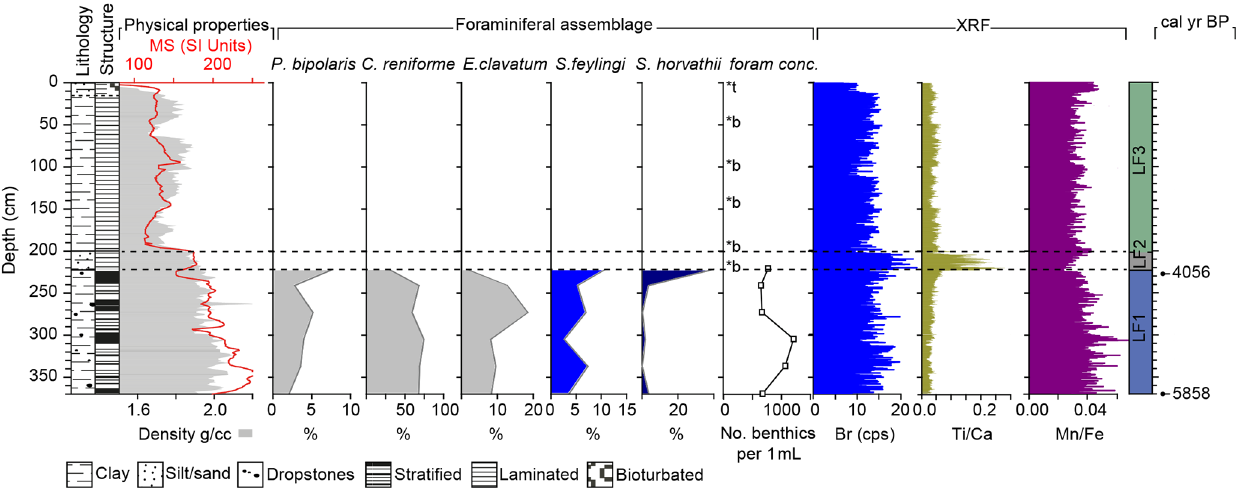
Figure 4. Multi-proxy data for core LC7, including simplified core lithology/structure, physical properties (magnetic susceptibility (MS) and density), foraminiferal assemblage data (barren (b) and trace (t; < 20) foraminifera), and selected XRF-scanner data. Horizontal (dashed) lines delineate the main lithofacies (LF) 1–3. Calibrated ages are shown on the right panel.